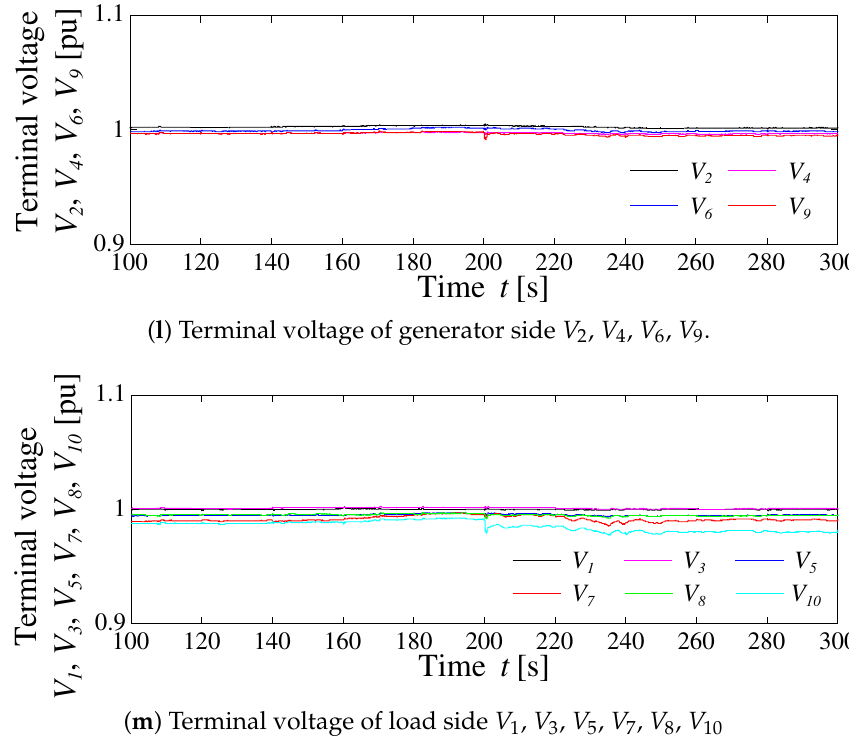
Figure 16. Simulation result (with battery and demand response).